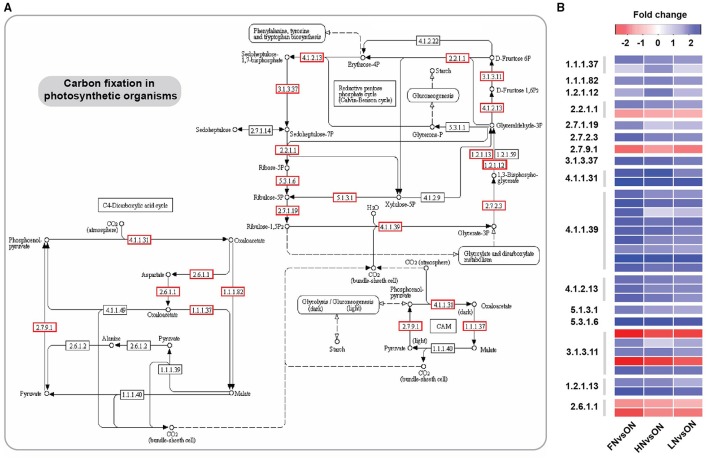
Differentially expressed genes (DEGs) participating in carbon fixation in photosynthetic organisms under varied N treatments. (A) The pathway of carbon fixation in photosynthetic organisms. Red panes represent the DEGs. (B) The expression pattern of DEGs involved in carbon fixation in photosynthetic organisms.